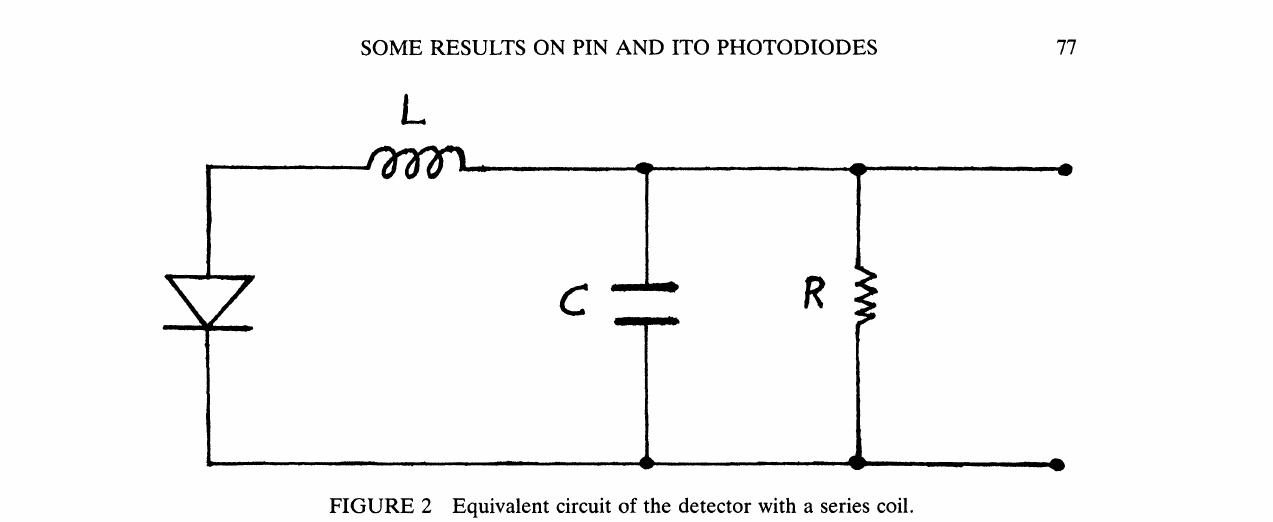
FIGURE 2 Equivalent circuit of the detector with a series